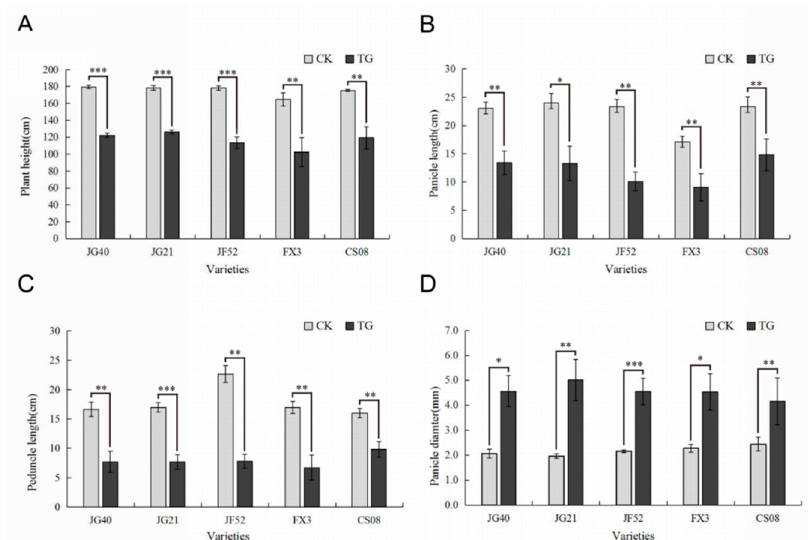
Figure 2. Phenotypes of downy mildew-resistant and -susceptible foxtail millet varieties. ( A ) Plant heights, ( B ) panicle diameters, ( C ) panicle lengths, ( D ) panicle internode lengths of resistant and susceptible foxtail millet cultivars. CK, control plants; TG, infected plants. Expression levels were analyzed using a T-test. Within each figure, asterisks above bars indicate statistical significance (*, p < 0.05; **, 0.01 < p < 0.05; ***, p < 0.01); Experiments were repeated at least three times with similar results.